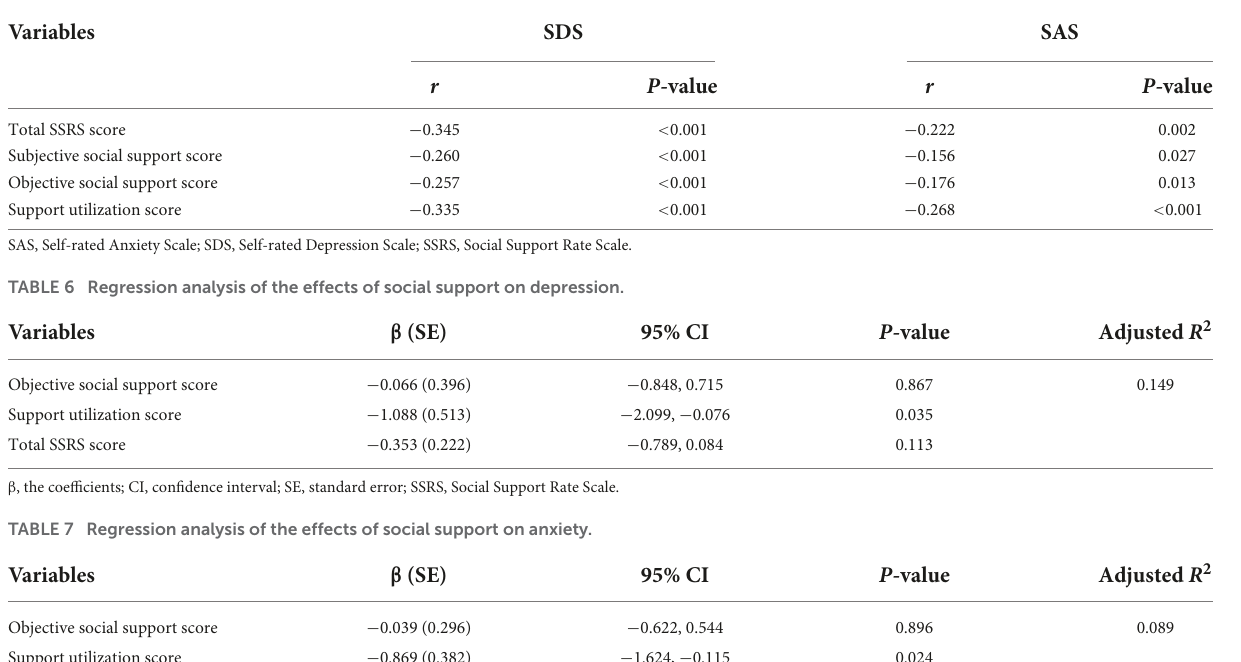
TABLE 5 Correlations between social support, anxiety, and depression.